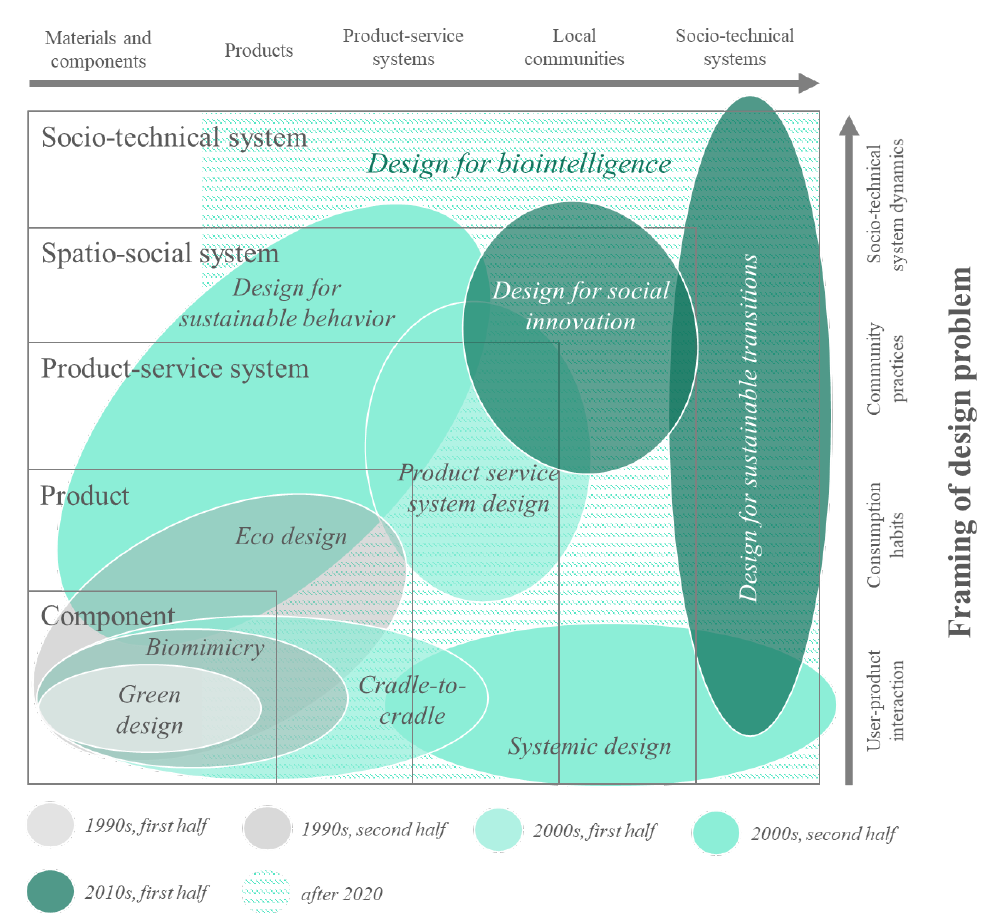
Figure 7. Evolution of sustainable design approaches according to Ceschin and Gaziulusoy [65] and scope of ‘design-for- biointelligence’ .